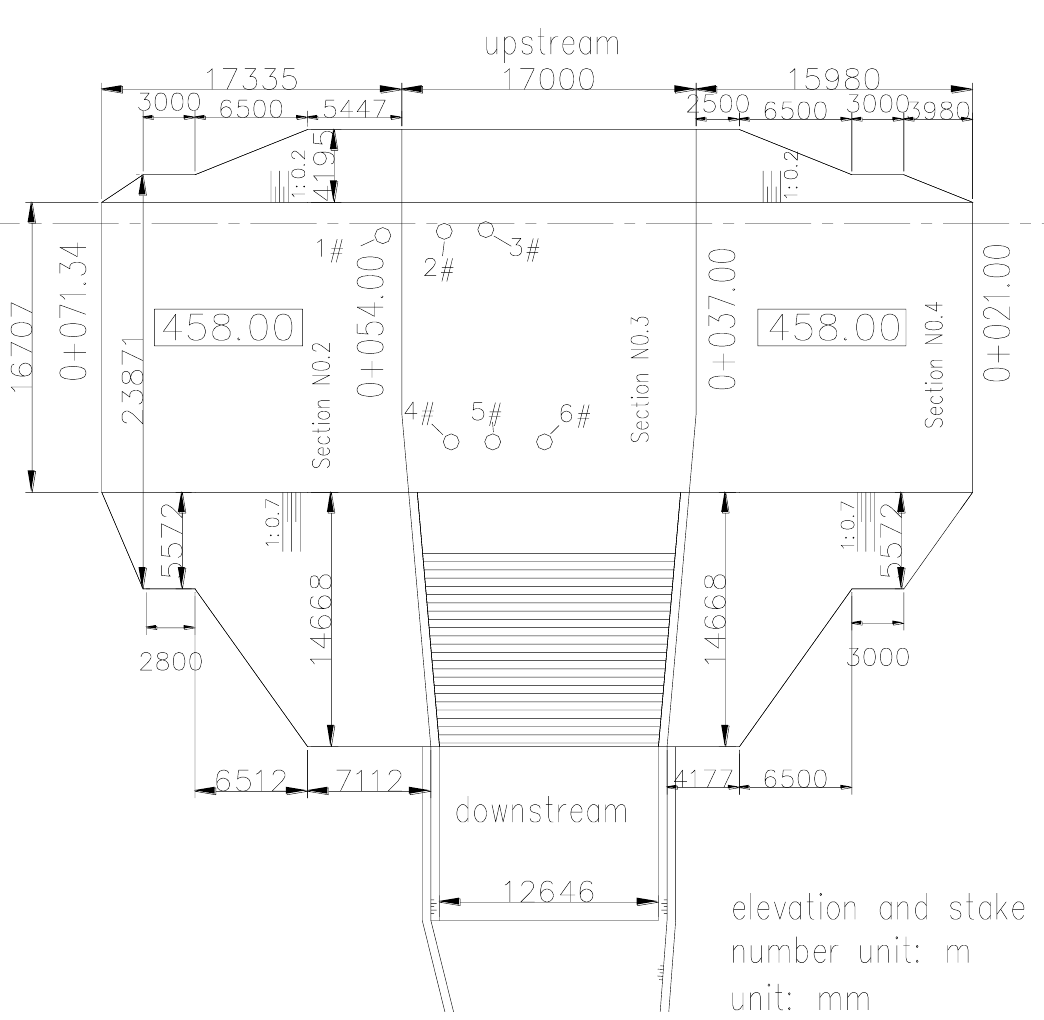
Figure 5. Layout of boreholes at the Hantang dam.